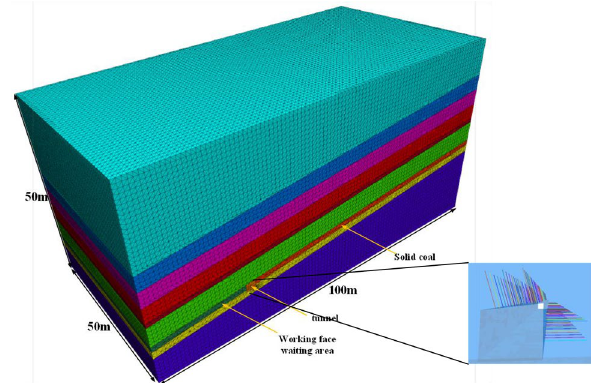
Figure 9. Schematic diagram of numerical calculation model.